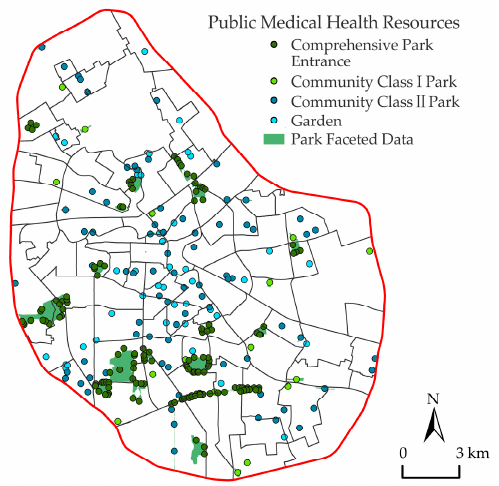
Figure 3. Spatial distribution of public natural health resources in the research